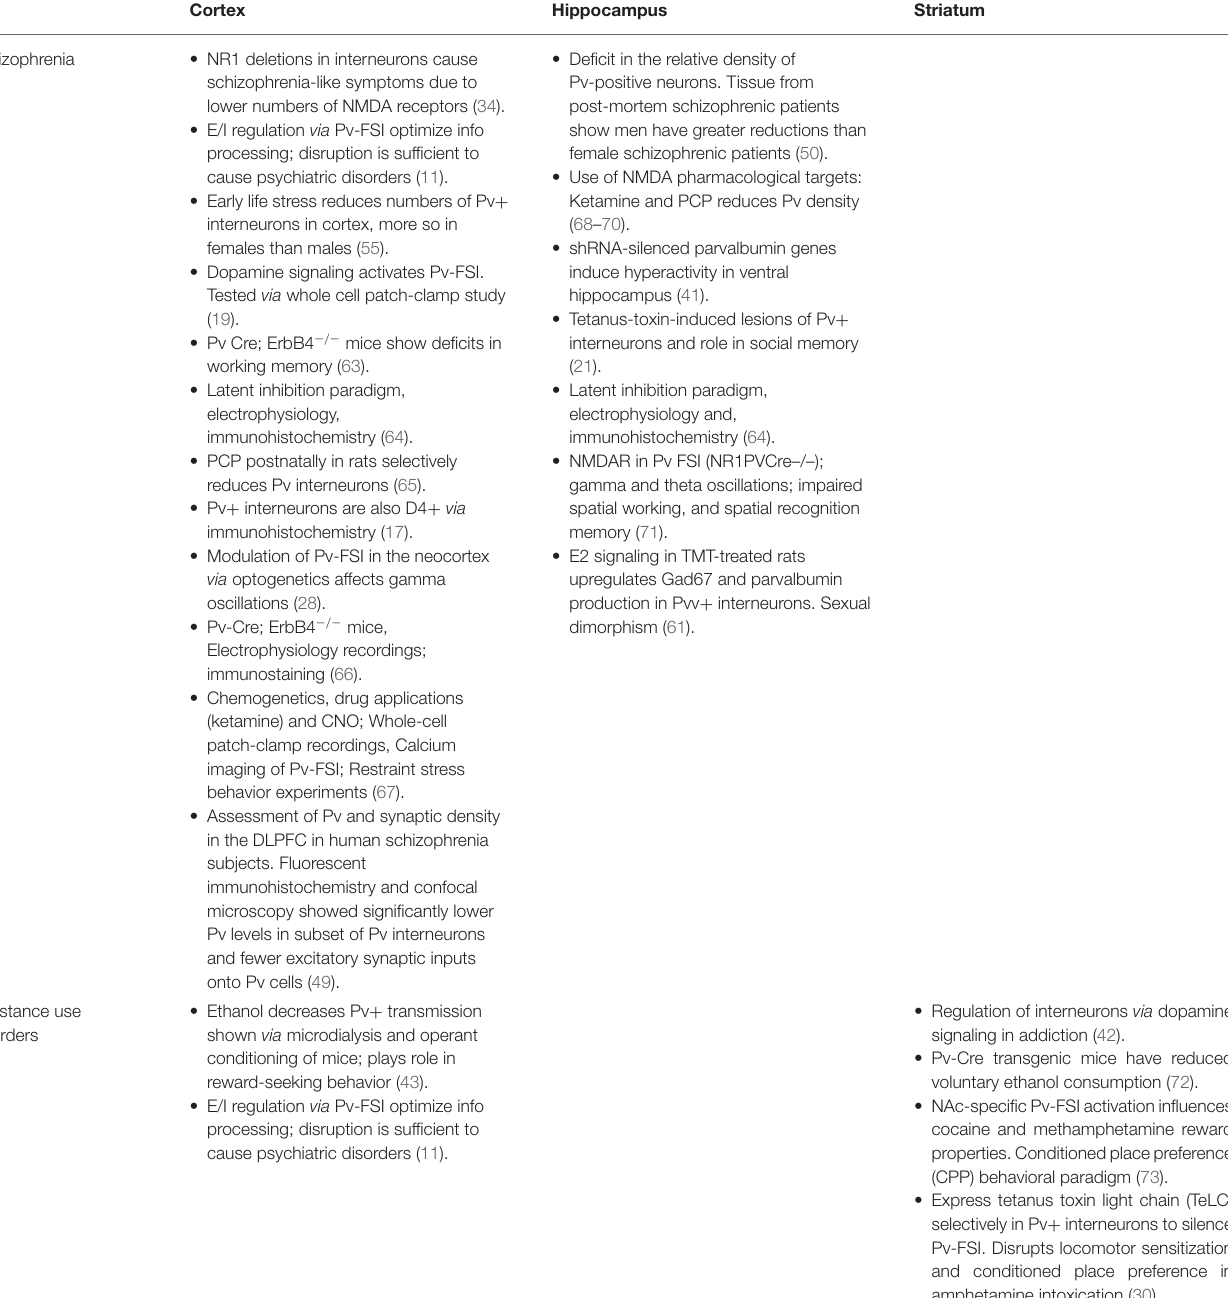
TABLE 1 | The role of Pv-FSI in neurological and psychiatric